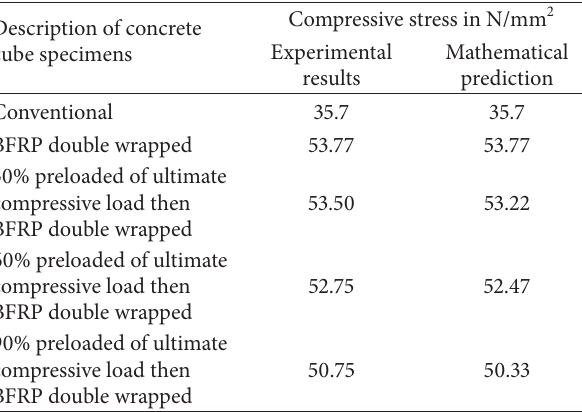
Table 8: Concrete specimens compressive stress comparison between experimental results and mathematical